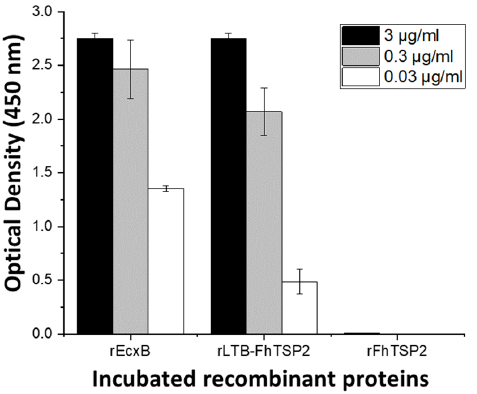
Figure 3. Characterisation of pentamer formation of the rLTB ‐ FhTSP2 fusion complex via glycan receptor binding. Plates were coated with 3 μ g/mL of GM1 ganglioside and blocked with 3% bovine serum albumin. Potential binding proteins (rEcxB and rLTB ‐ FhTSP2) and negative control (rFhTSP2) were incubated in triplicate at three dilution factors (3, 0.3, and 0.03 μ g/mL). Binding was detected by mouse anti ‐ His tag HRP conjugated antibodies. All results are displayed as the mean of the adjusted optical density after subtraction of non ‐ GM1 coated wells.